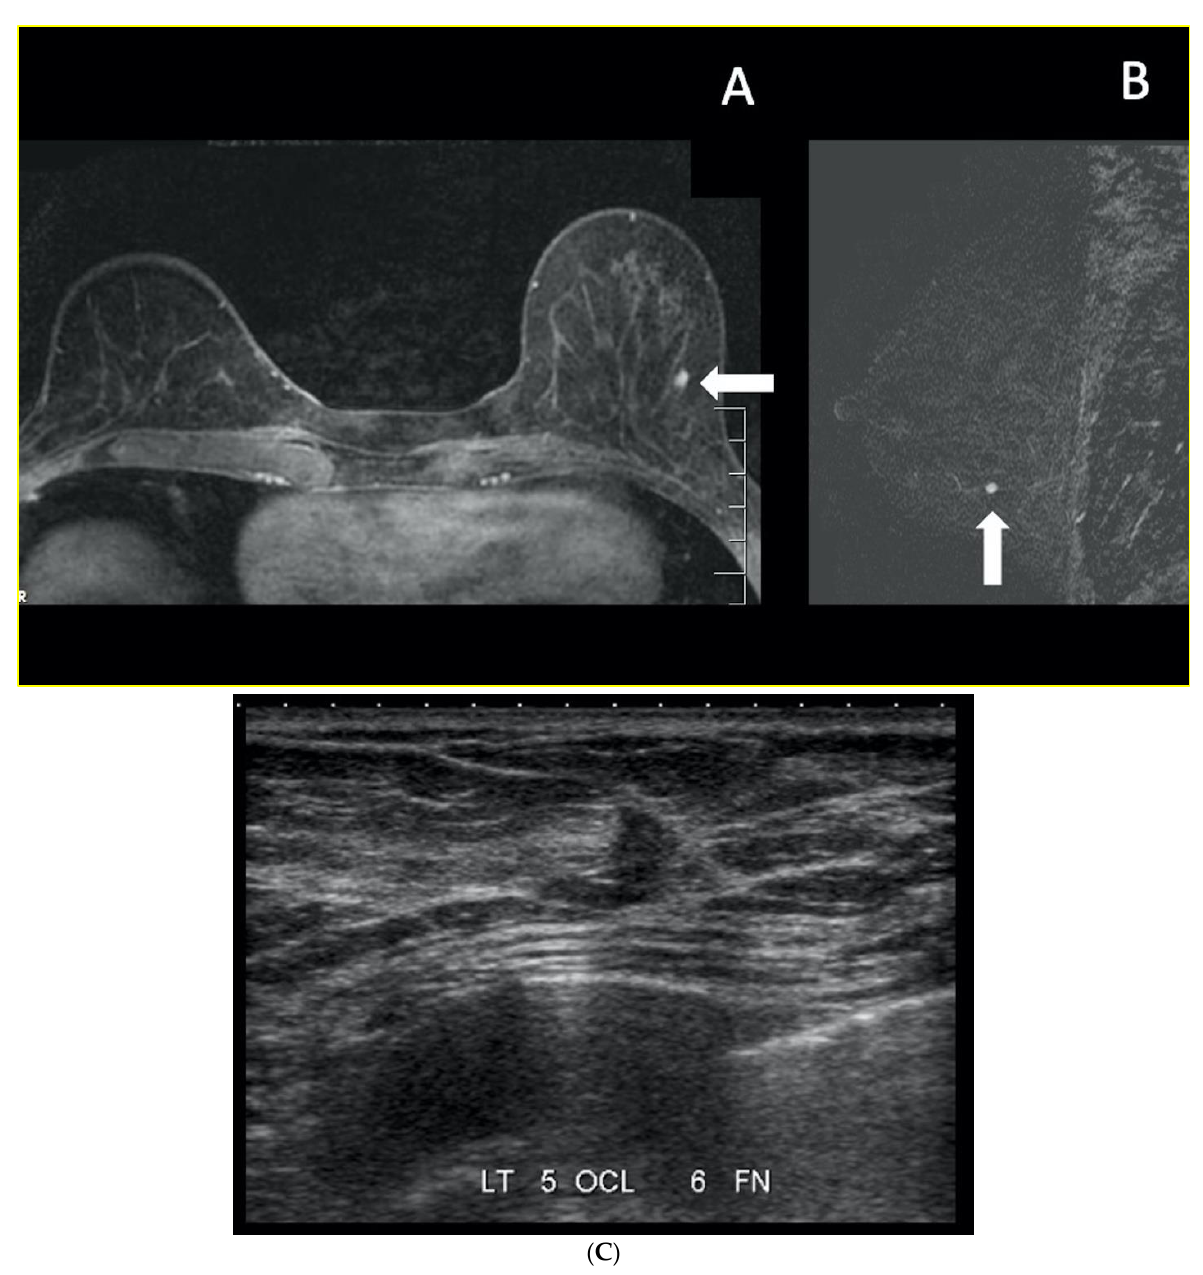
Figure 7. Courtesy of Dr. Anabel Scaranelo. High-risk screening with breast MRI in a 52-year-old woman with a family history of breast cancer in her sister. Screening mammography (not shown) was negative, with category C density. Focus of enhancement (arrow) in the lower outer quadrant of the left breast, ( A ) axial and ( B ) sagittal T1-weighted 3D-gradient echo with fat saturation 2nd minute post contrast. ( C ) The patient was recalled for a second look ultrasound that showed correlation with a suspicious subcentimeter mass lesion at 5 o’clock (arrows). An ultrasound-guided core needle showed grade 2 invasive ductal carcinoma.